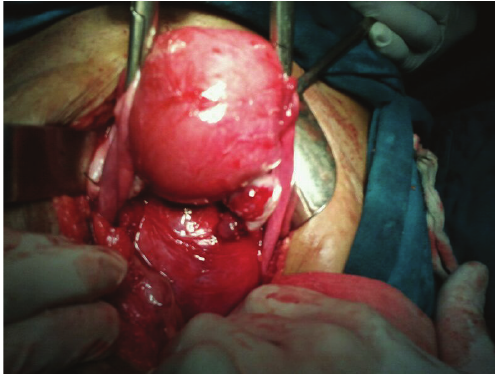
Figure 1: Uterus and retroperitoneal leiomyoma on initial appear- ance.